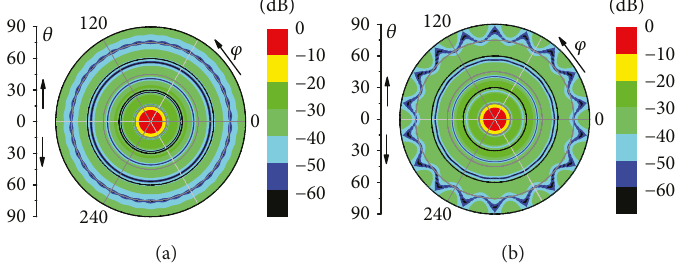
Figure 4: Power patterns of SUACRA 1 and 2: (a) SUACRA 1 and (b) SUACRA 2. Table 2: Initial and optimized parameters of SUACRA 1 and